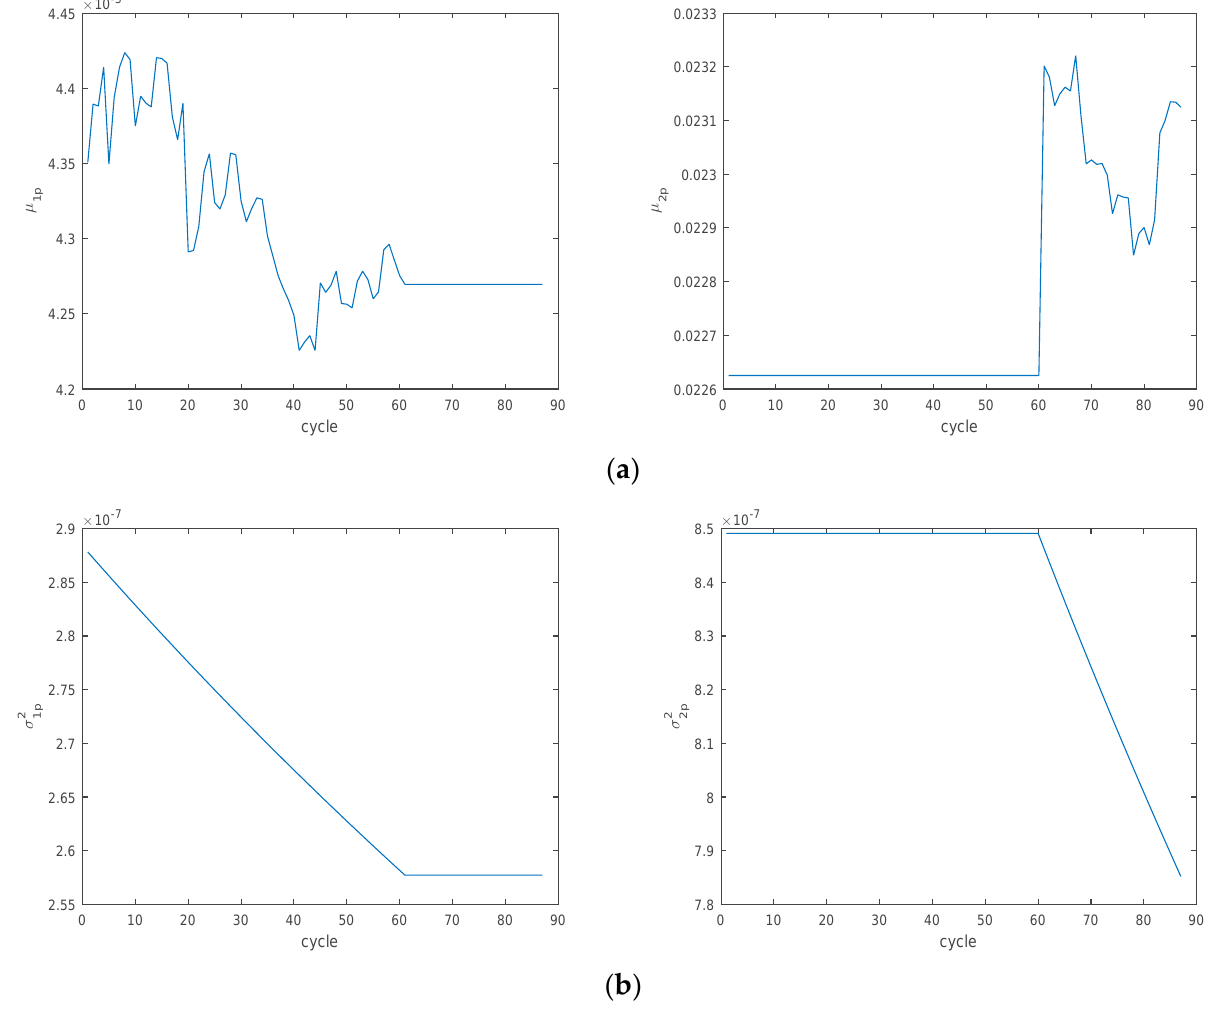
(cid:16) (cid:17) (cid:16) (cid:17) ~𝑁(𝜇 , 𝜎 (cid:2869),(cid:3043)(cid:2870) ) and 𝜇 ~𝑁(𝜇 , 𝜎 (cid:2870),(cid:3043)(cid:2870) ) . ( a ) Updating µ 1, p , σ 2 µ 2, p , σ 2 and µ 2 ∼ N . ( a ) Updating of µ 1, p and µ 2, p , (cid:2869) (cid:2869),(cid:3043) (cid:2870) (cid:2870),(cid:3043) 2, p 1, p